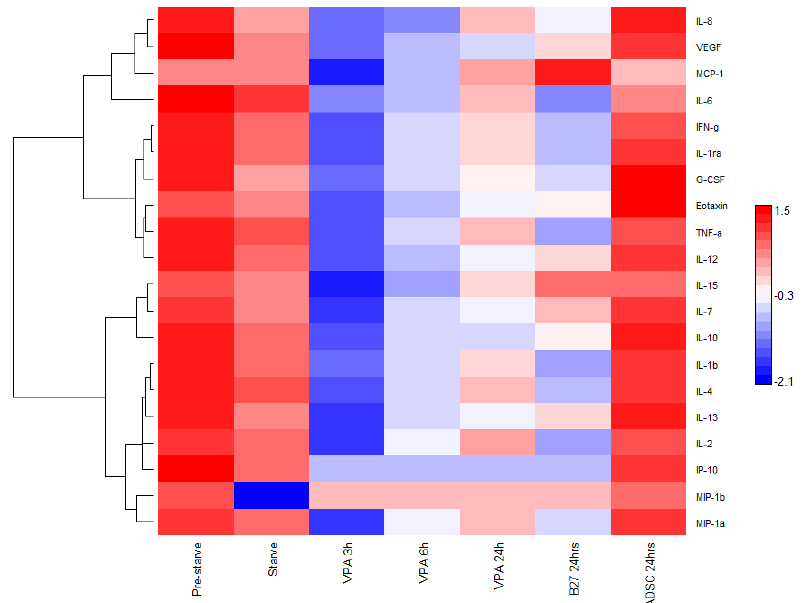
Figure 3. A Bioplex heat map of the log10 measure of cytokines and interleukins expressed in ADSCs in control DMEM media pre FBS starved; starved and in DMEM after 24 h or treated with B27 or VPA over time. Hierarchical clustering software and a Euclidean test. Red: expression above median;